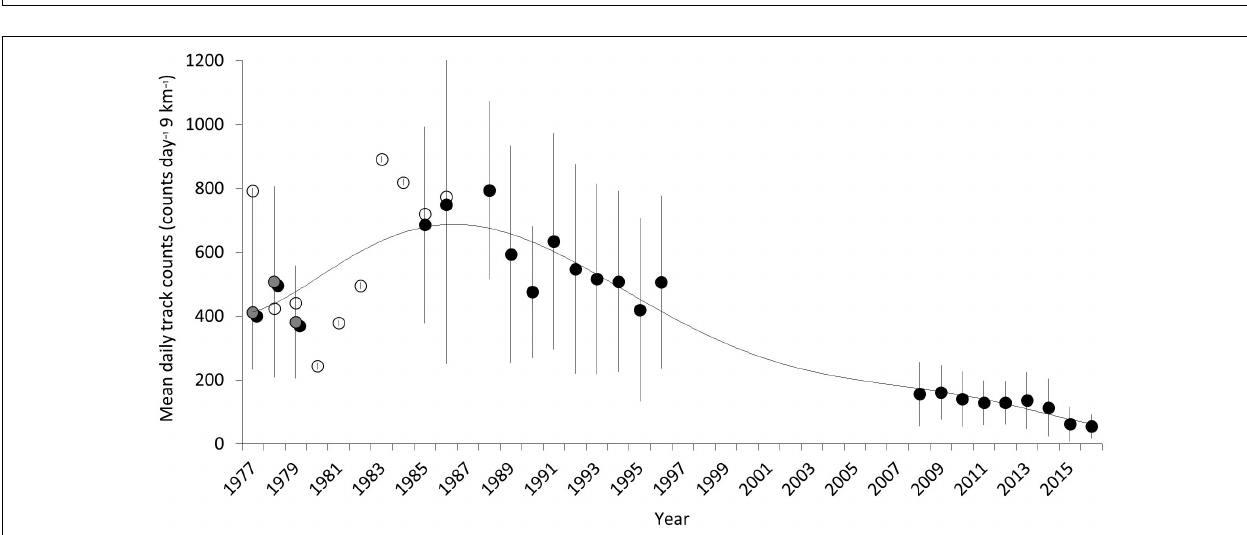
FIGURE 9 | Ordinal dates of surveys for each year included within the long-term track count trend assessment for Masirah loggerheads (1977–2016). Dashed line represents mean of ordinal date across all years.